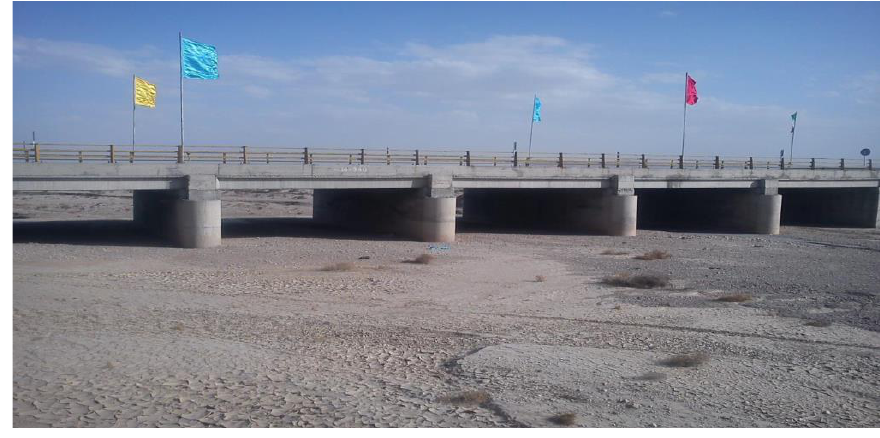
Figure 13. The structure of bridge No. 3.